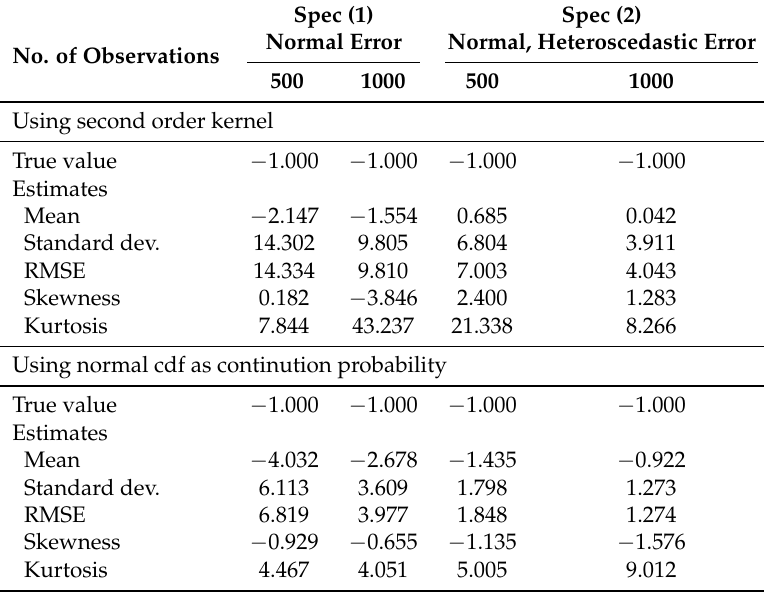
Table 3. Simulation summary statistics—parameter: coefficient on ( s /100 ) 2